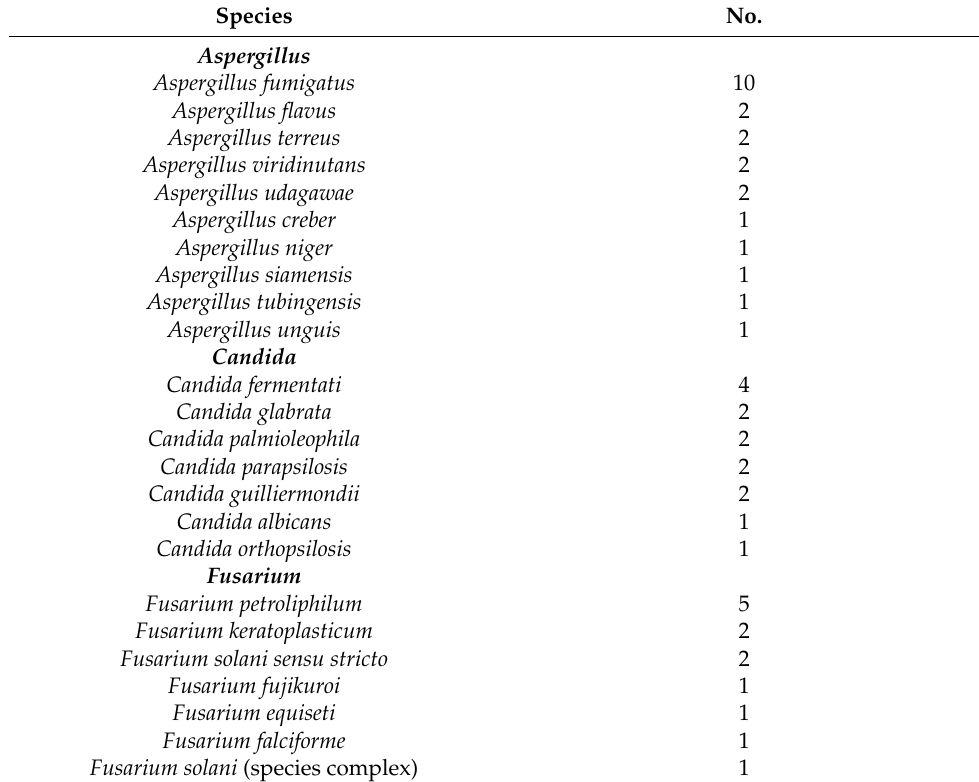
Table 4. Causative species of Aspergillus , Candida , and Fusarium